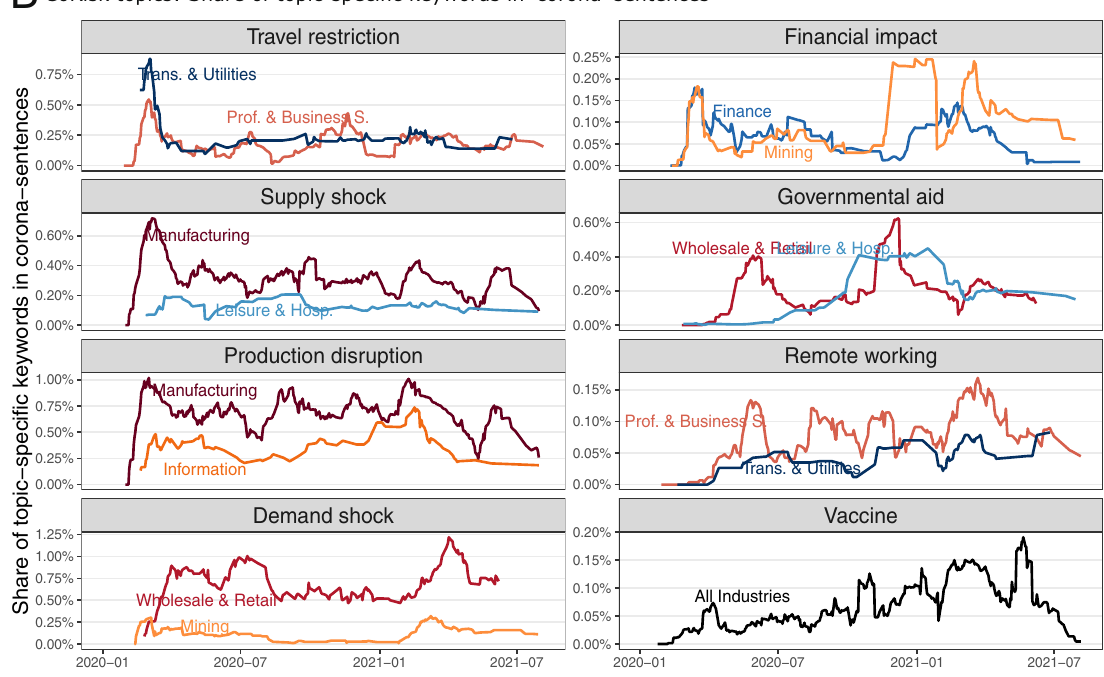
Fig. 2 The CoRisk-Index reveals the dynamics of the economic crisis in different industries. A The CoRisk-Index: a composite measure of industry- speci fi c business risks. It shows how industries differ in timing and magnitude of risk awareness towards Covid-19 together with smoothed trend lines (dotted). B CoRisk topics: the share of domain-speci fi c keywords in ‘ corona ’ sentences of 10-K reports. The data re fl ects the relevance of the different dimensions of the crisis for the eight considered industries over